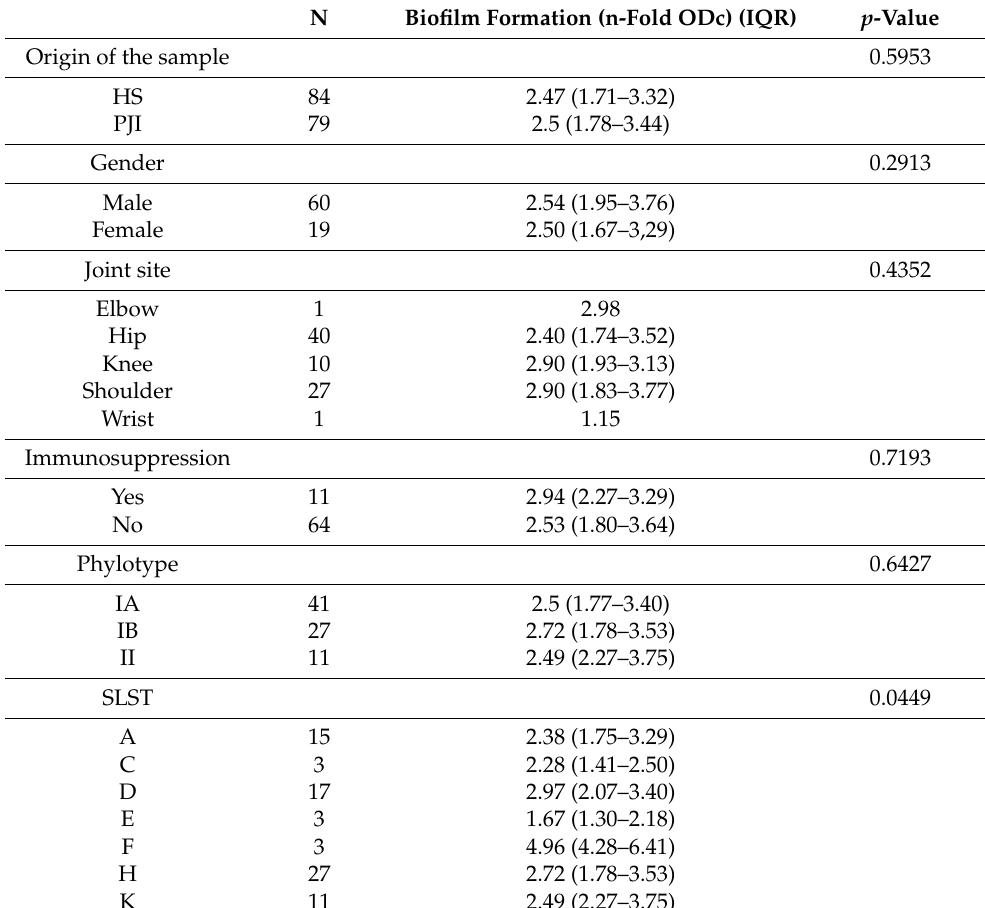
Table 1. Biofilm Formation according to Origin of the Sample, Gender, Joint Site of Infection, Immunosuppression of the Patient, Strain Phylotype, and SLST Class.